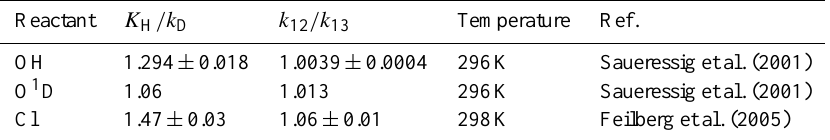
Table 2. Kinetic isotope effect ratios of methane with OH, O 1 D, and Cl. Reactant K H /k D